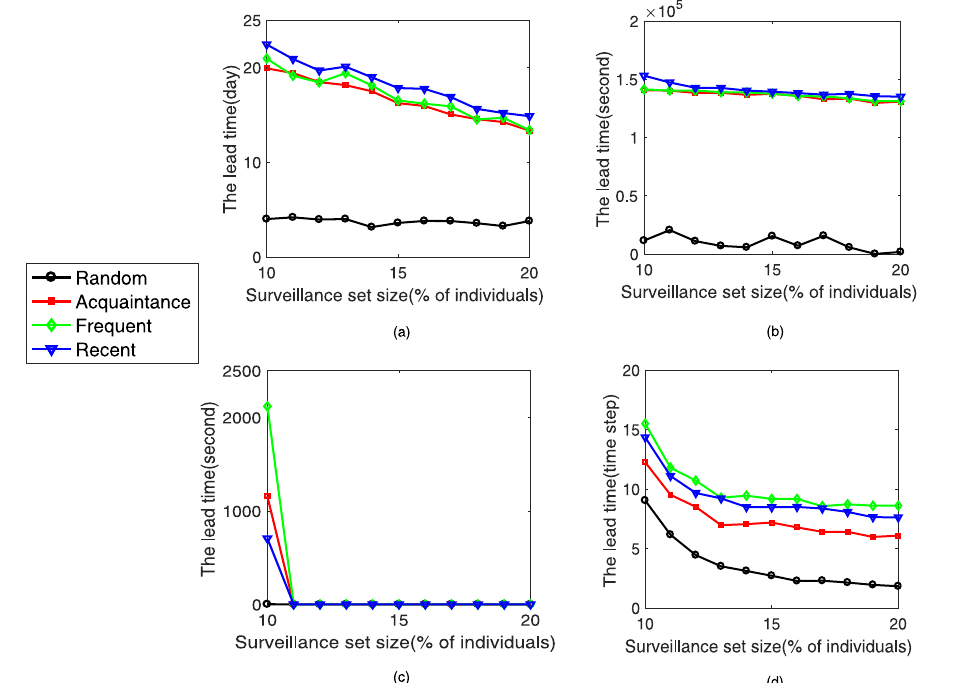
Figure 4. The size of surveillance set impacts performance. How the lead time improves as the surveillance set expands in the ( a ) Prostitution network, ( b ) Dating network, ( c ) Email network and ( d ) Synthetic network. The surveillance set was chosen by the Random (black), Acquaintance (red), Frequent (green) and Recent (blue) strategies.